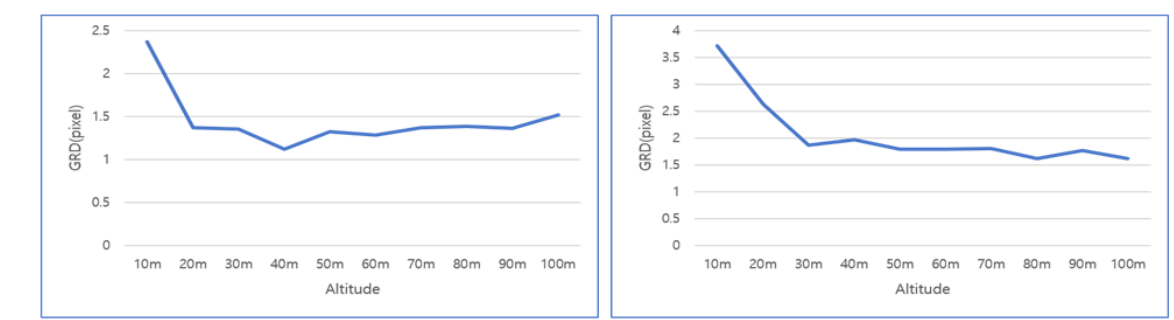
(b) GRD (pixel) by altitude in images of Second Drone shot Figure7. GRD(pixel) in the Second and Third drone